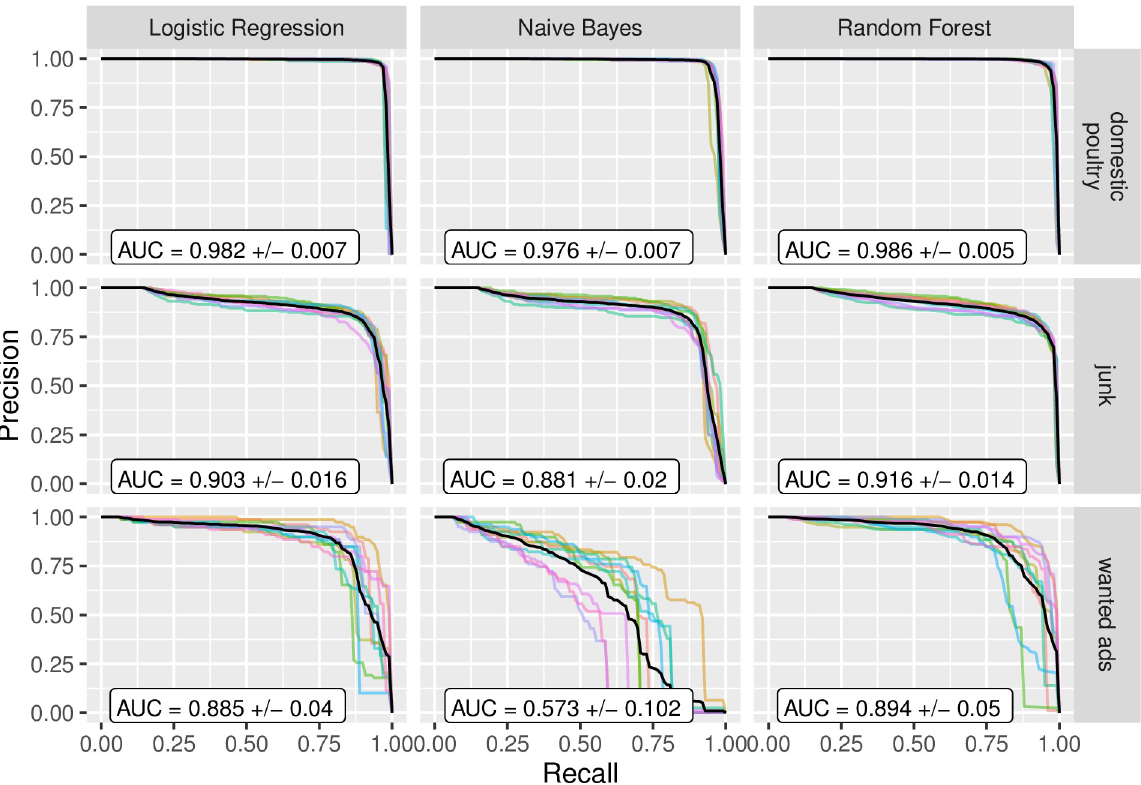
Fig 3. Precision recall curves and the area under the curve (PR AUC). Three different text classifiers (columns) were tested across three different labels (rows). For each panel, each line represents one cross-validation fold and the solid black line represents the average across all cross-validation folds. Average AUC (area under curve) values are reported with standard